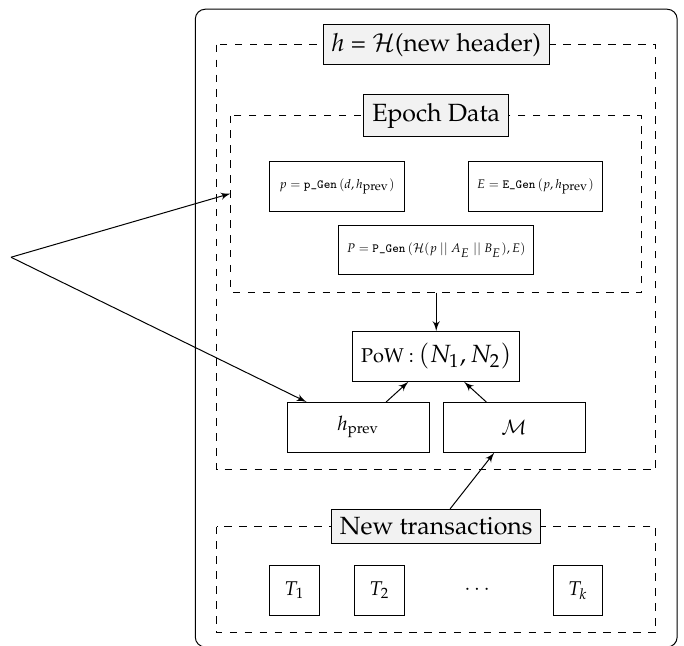
Figure 3. A Epoch Block [EB]